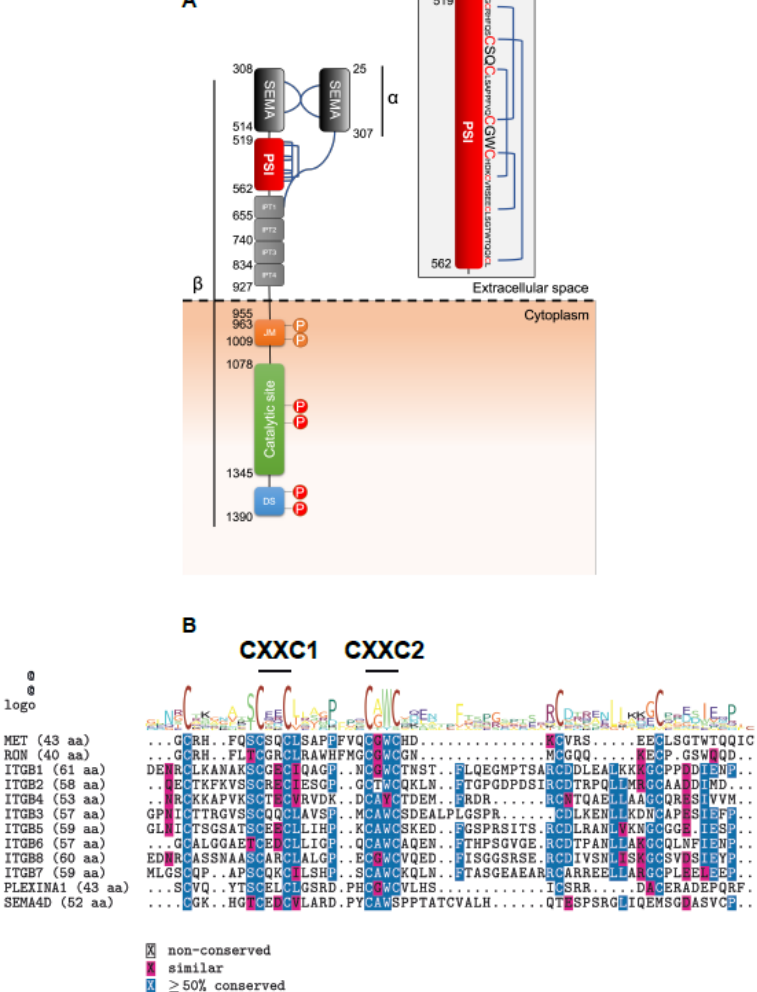
Figure 1. MET holds a Cys-rich, conserved PSI domain. ( A ) Schematics of MET. Interchain and intrachain disulfide bonds are presented in blue according to [1–3]. The PSI domain is exhibited as an insert, with cysteine residues in red and CXXC motifs in more prominent points. ( B ) PSI domain amino acid sequence alignment between the indicated proteins. Analyses were performed using the R package “msa” version 3.14 using the ClustalW algorithm [17]. Conserved amino acids are highlighted in blue, and biochemically similar amino acids are displayed in pink. The two CXXC motifs are shown above the consensus